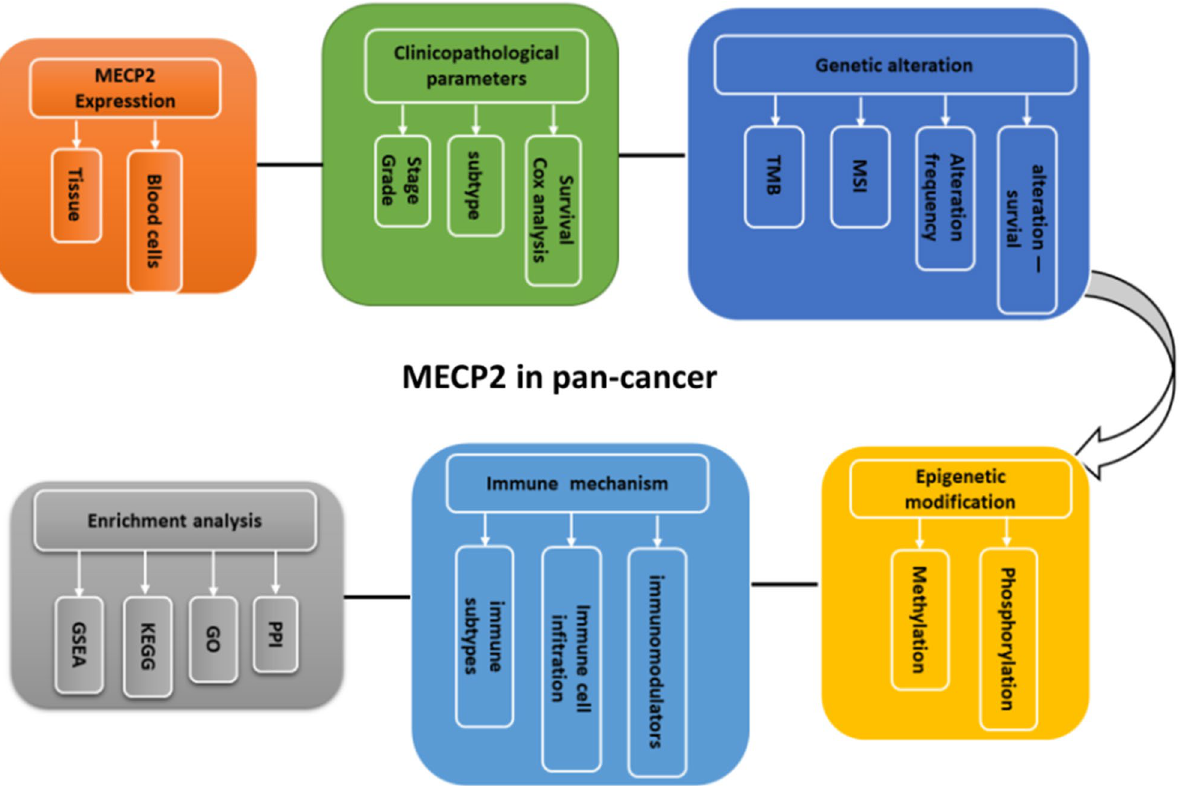
Figure 1. The workflow of the current study. MSI microsatellite instability, TMB tumor mutational burden, PPI protein–protein interaction, GO gene ontology, KEGG Kyoto Encyclopedia of Genes and Genomes, GSEA Gene Set Enrichment